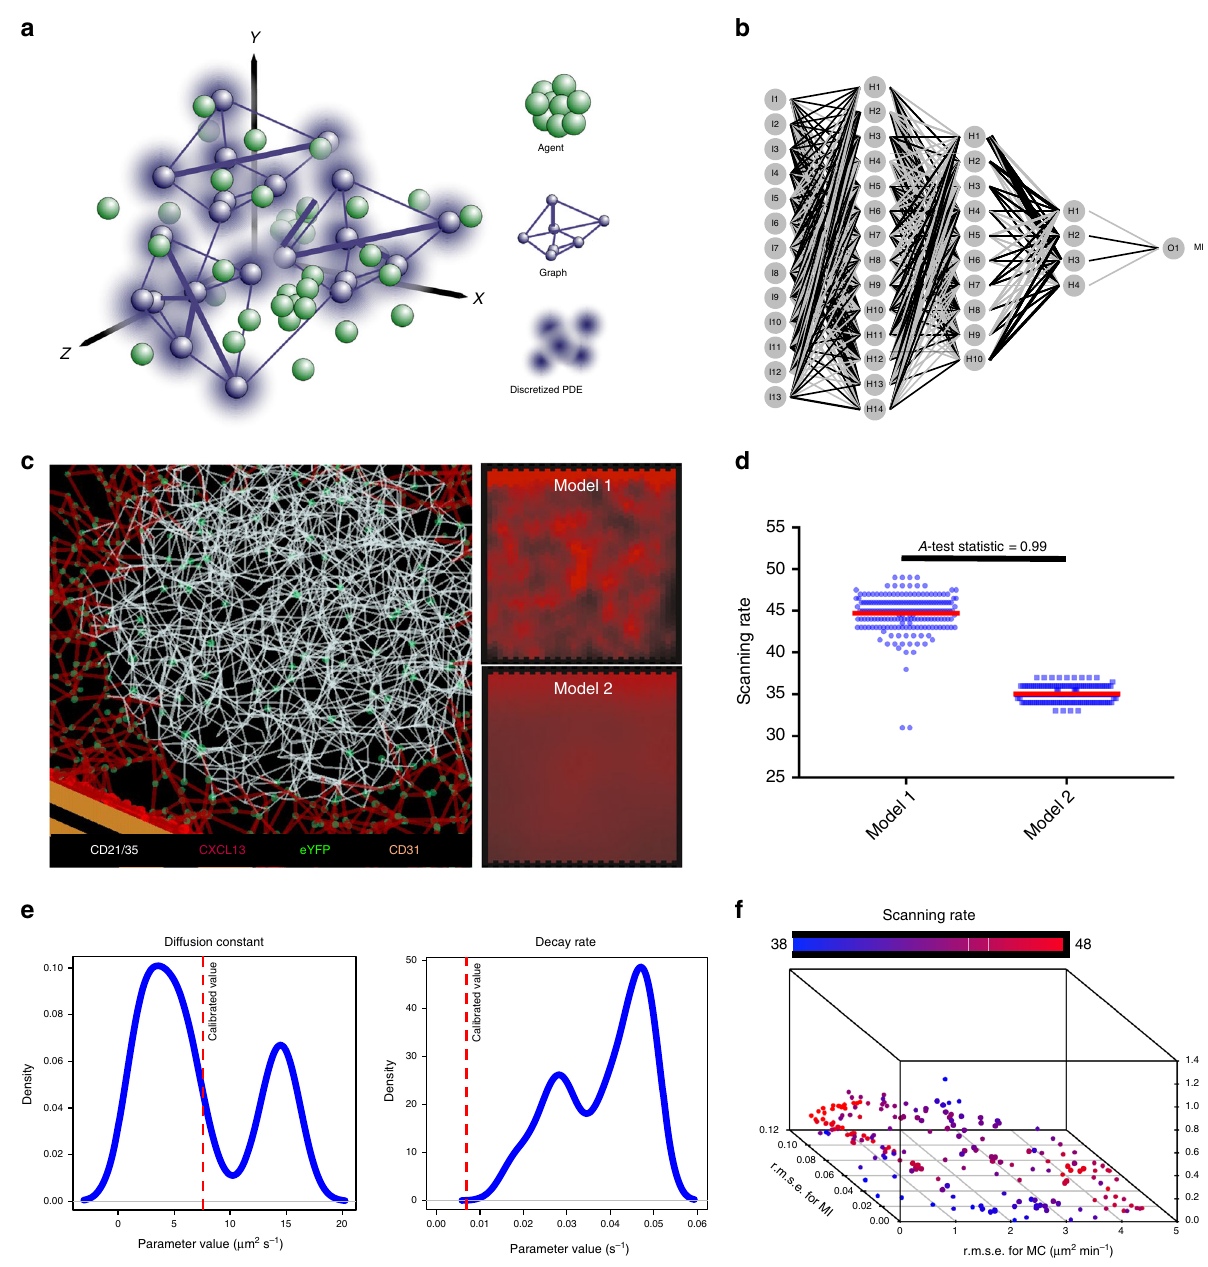
Fig. 2 Mapping CXCL13 spatial distribution through simulation analysis and multiobjective optimization. a Overview of the multiscale model platform. In this modular system stromal cells are modeled as a graph (Module 1), chemokine diffusion is modeled as a discretized partial differential equation (Module 2), while B cells are modeled as agents that can interact with their local environment through a set of coupled differential equations and vector- based calculations (Module 3). b Example structure of an arti fi cial neural network used to emulate CXCL13Sim. The network has 13 input nodes that connect to three hidden layers, and a single output node predicting the meandering index. A distinct network is created for each simulator output. The hyperparameters of the network were determined using k -folds cross-validation. c The in silico follicular stromal network with a chemotactic landscape created for models 1 and 2 by the network. d Comparison of scanning rates in silico for models 1 and 2. Each parameter set was run 200 times with signi fi cance assessed using the Vargha − Delaney A-test 70 . The test statistic (0.99) exceeds the threshold for a large effect size (0.71). Bar plots represent the median value for the emergent scanning rate and the error bars represent the IQR. e Parameter distributions for diffusion and decay rates corresponding to the Pareto optimal solutions shown in ( f ) with calibrated values for each parameter shown using the dotted red line. f Using a MOEA scheme we seek to address the following four objectives: minimize the root mean squared error between emulator and simulator responses for cell speed, meandering index and motility coef fi cient; and maximize scanning rates. The Pareto front of solutions represents the trade-off in performance between cell behaviors and scanning rates, using NSGA-II (emulation pipeline described in Supplementary Fig. 1). Source data are provided as a Source Data fi